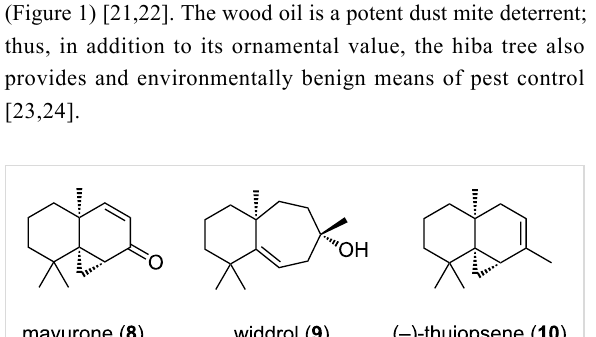
( − )-Thujopsene ( 10 ) has attractive features to the synthetic chemist. Its tricyclo[5.4.0.0 1,3 ]undecane skeleton contains